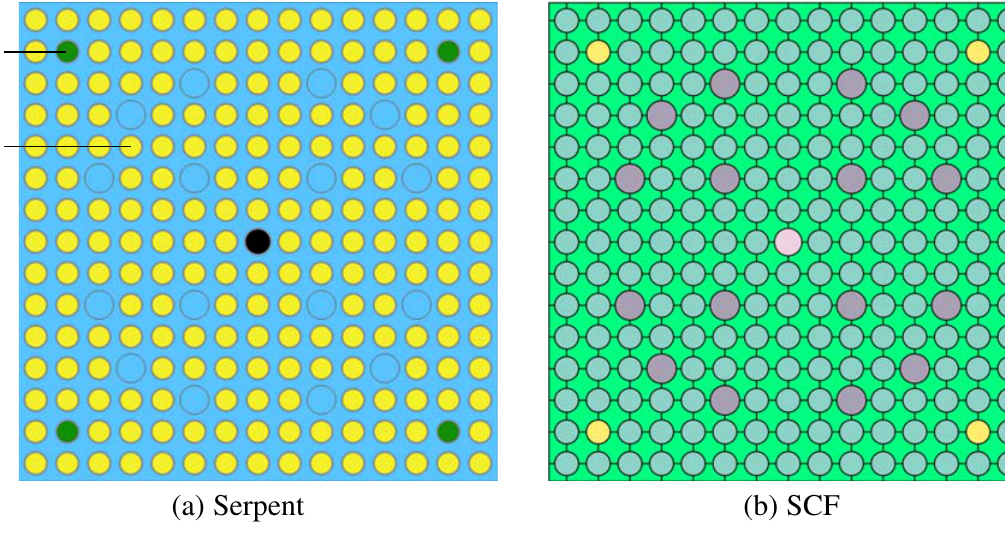
Figure 1: Test Case